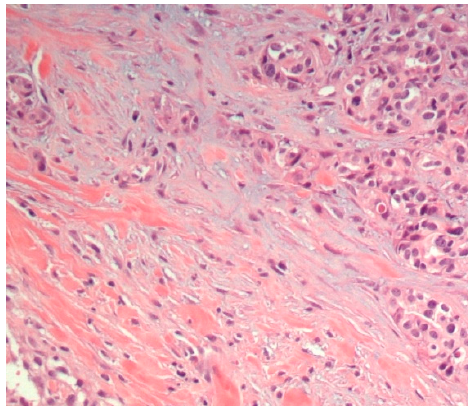
Figure 1. Mammary gland, complex adenoma (HE staining, 200×). There are epithelial (tubular) and myoepithelial cell propagation. The myoepithelial cells are fusiform to stellate and are surrounded by a basophilic mucinous matrix.